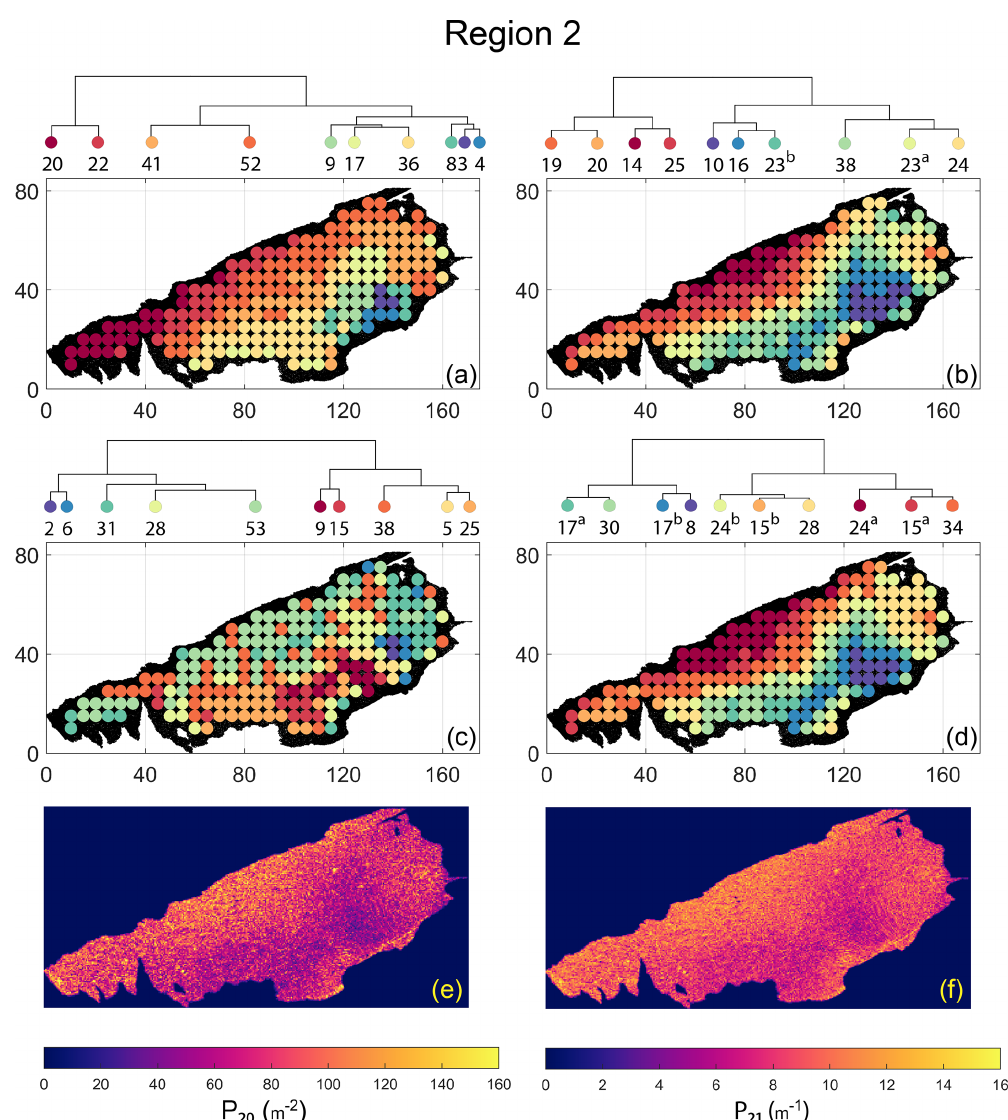
Figure 19. Hierarchical clustering results for Region 2 depicting the top 10 clusters using (a) fingerprint distance, (b) D-measure distance, (c) NetLSD distance, (d) portrait divergence distance, (e) spatial P 20 , and (f) spatial P 21